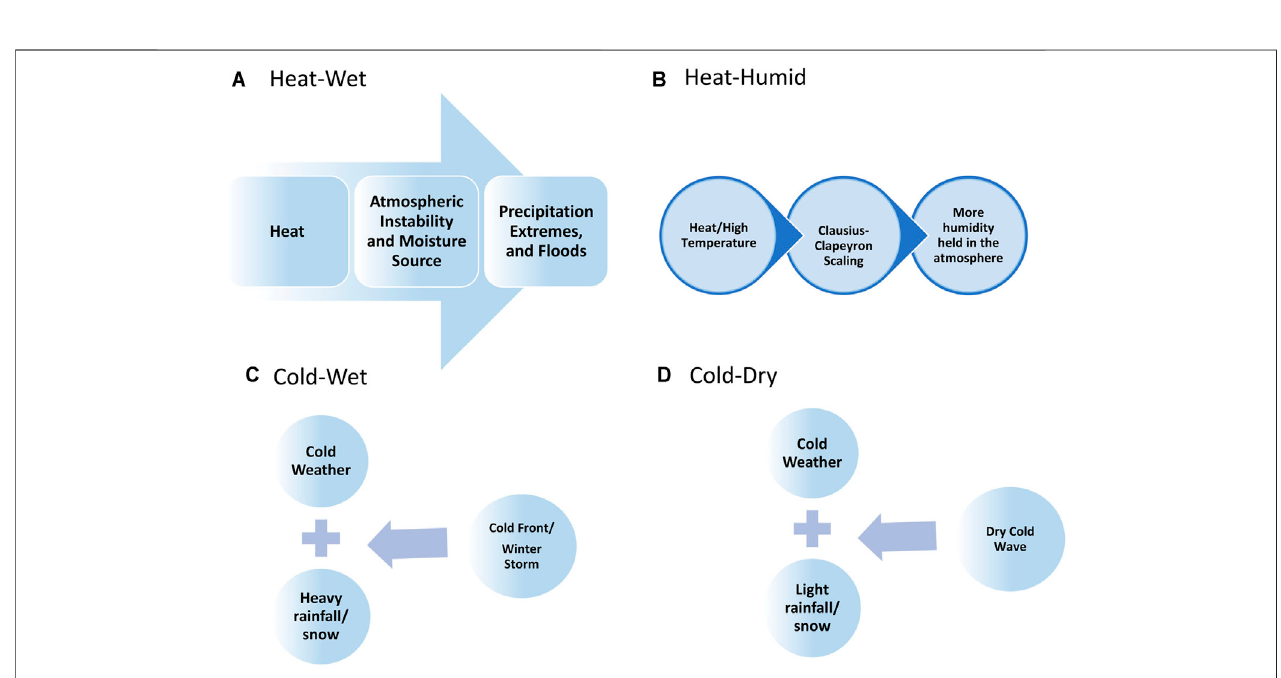
FIGURE 2 | Schematic of compound hydrometeorological extremes: (A) heat-wet (Soneja et al., 2016; Wang S. S.-Y. et al., 2019; Imada et al., 2019; Zhang and Villarini,2020;Chenetal.,2021), (B) heat-humidextremes(FischerandKnutti,2013;Lietal.,2020;PoppickandMcKinnon,2020;Yuanetal.,2020), (C) cold-wet(Bisci et al., 2012; Hao et al., 2018; Hochman et al., 2019; De Luca et al., 2020) and (D) cold-dry (Dabhi et al., 2018; Wu Y. et al., 2021; Potopová et al., 2021). The Clausius- Clapeyron scaling represents the water holding capacity of the atmosphere corresponding to air temperature changes (Held and Soden, 2006).